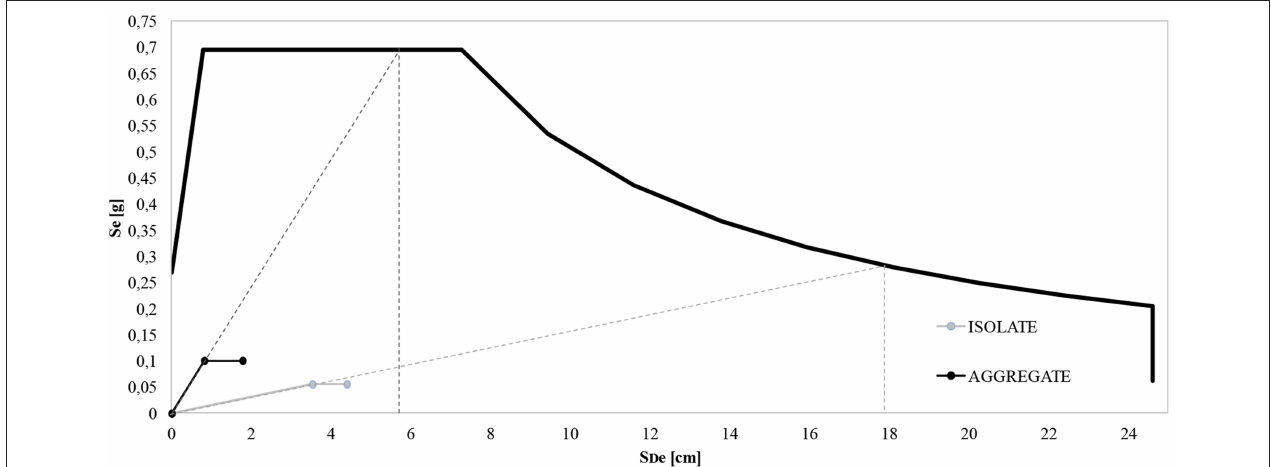
FIGURE 9 | Comparison between capacity curves of the bell tower in the ADRS format.